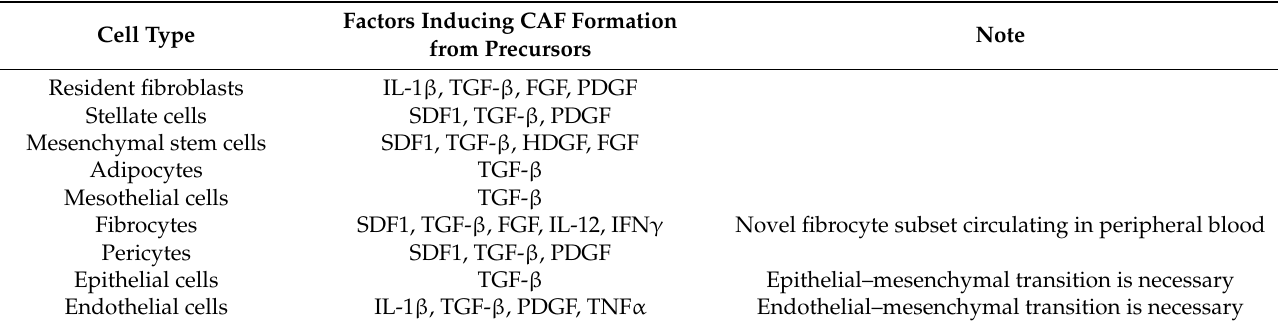
Table 1. Cell types as potential precursors for CAF